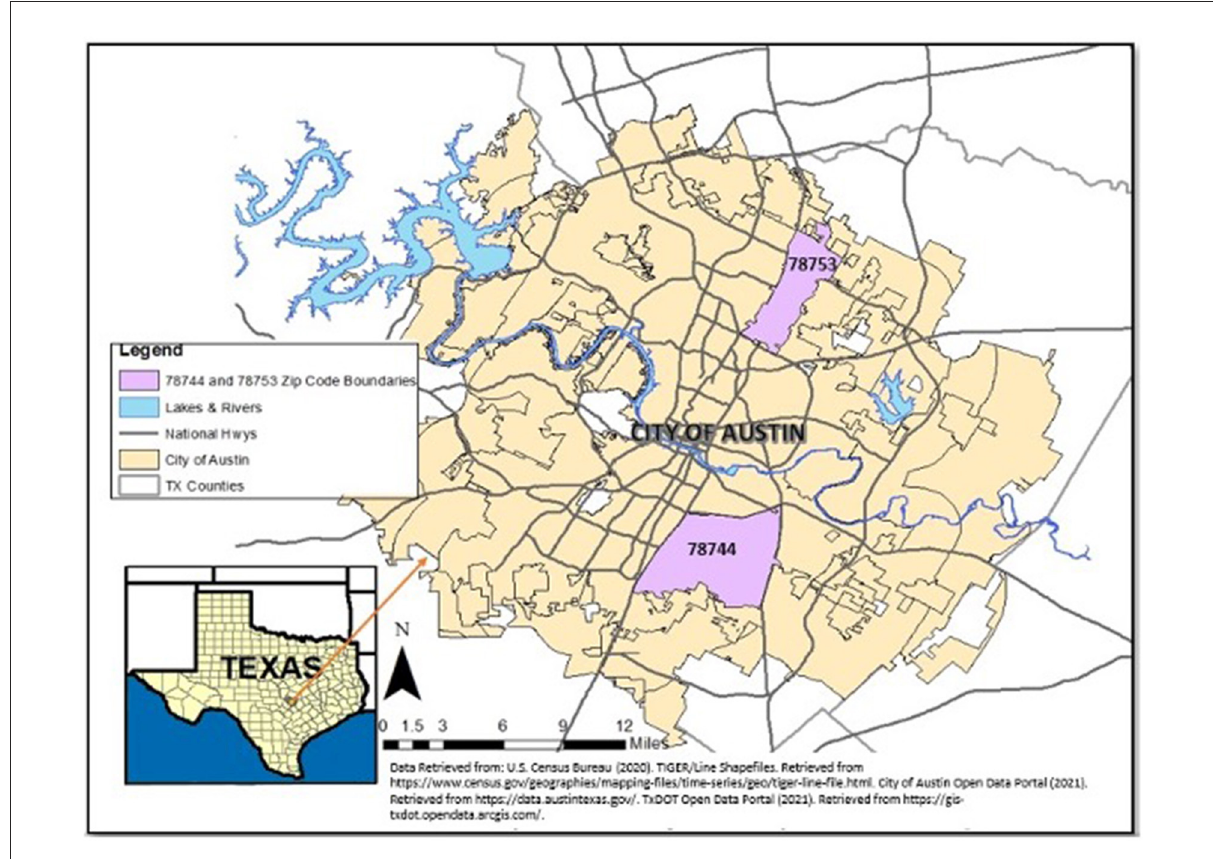
FIGURE4 Zip codes where GAVA activities are focused and adaptive capacity indicators were